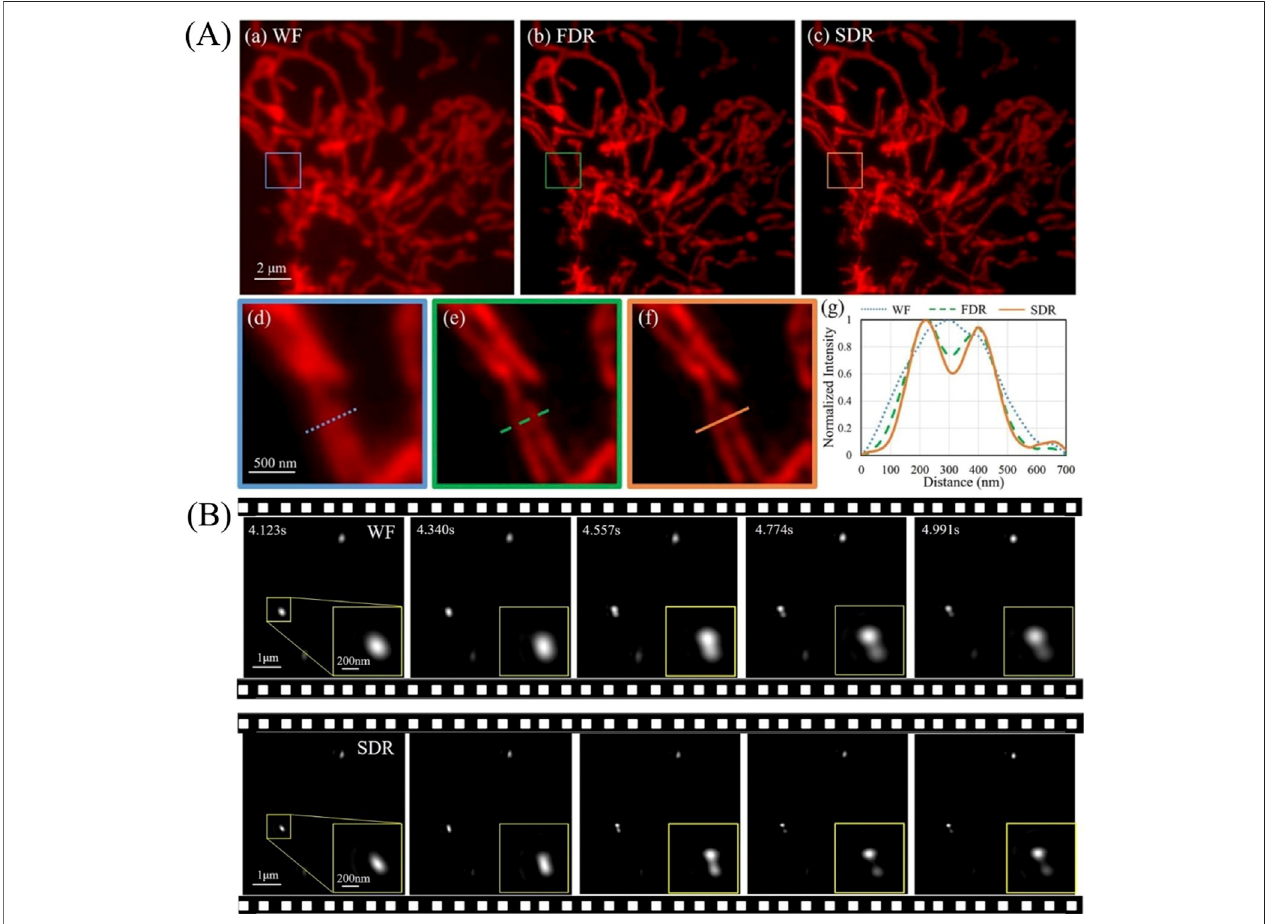
FIGURE 10 | SDR resolves fi ne details better than FDR in both static and dynamic imaging [71]. (Ai – iii) Images reconstructed by wide- fi eld, FDR- and SDR-SIM, respectively. (Aiv – vi) The magni fi ed views in the boxed regions in (Ai – iii) . (Avii) Intensity pro fi les along the marked lines in (Aiv – vi) . (B) SDR enables the resolution of beads. Five time-sequential frames in an interval of 217 ms are shown. The zoom-in boxes display the relative position variance of two adjacent beads.